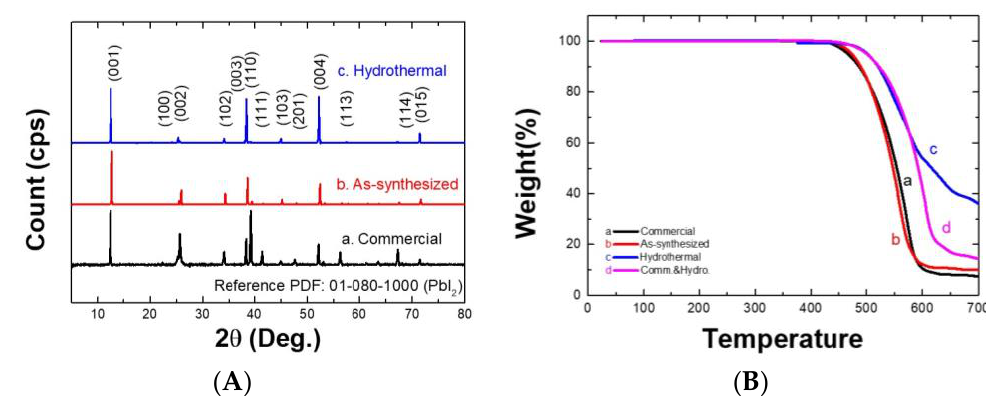
Figure 1. ( A ) X-ray diffraction patterns of a. commercially available PbI 2 (99.99% purity), b. as-synthesized PbI 2 without purification process, and c. crystallized PbI 2 after hydrothermal. ( B ) Thermogravimetric analysis (TGA) curves for commercially available PbI 2 (99.99% purity), b. as-synthesized PbI 2 without purification process, c. crystallized PbI 2 after hydrothermal, and d. commercially available PbI 2 (99.99% purity) with an additional hydrothermal process for comparison.